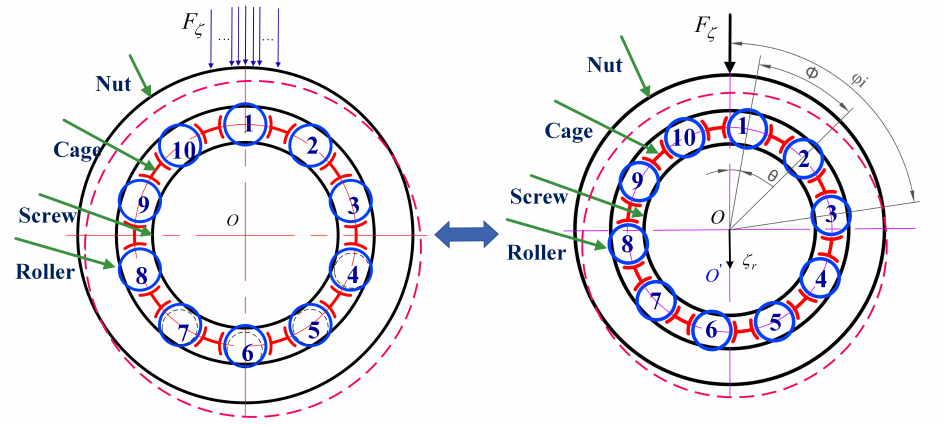
Figure 7. The diagram of deformation when subjected to radial